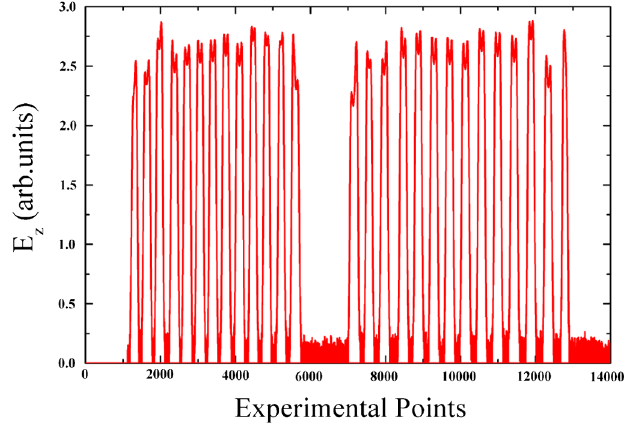
FIG. 42. The measured field distribution of the zero H mode.